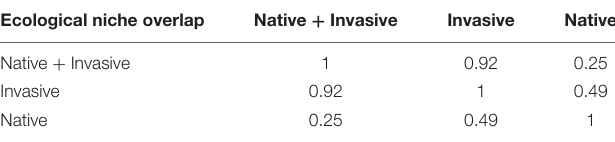
TABLE 1 | Ecological niche overlap of Rapistrum rugosum